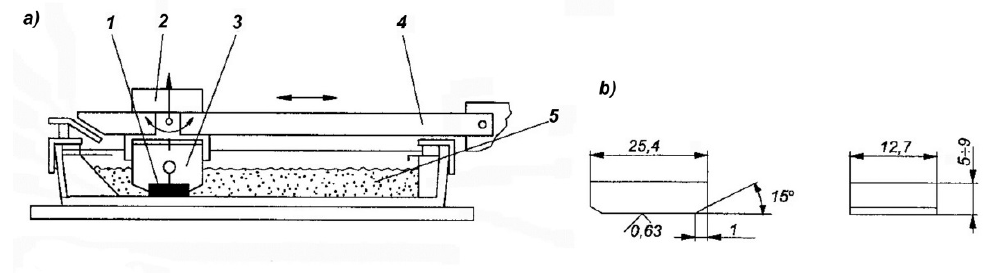
Figure 3. Diagram of the machine used in the Miller test. ( a ): 1 ; specimen, 2 ; weight, 3 ; specimen holder, 4 ; holder arm, and 5 ; abrasive. ( b ) dimensions of the specimen tested for abrasive wear.